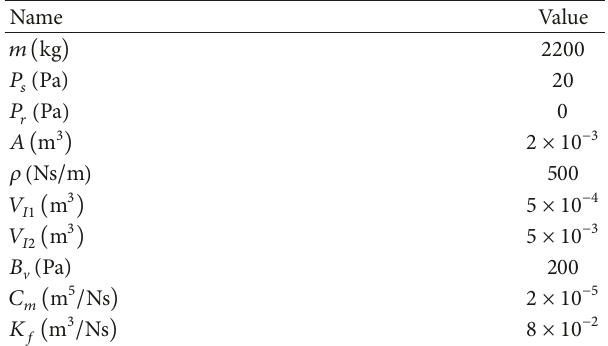
Table 1: The system parameters used in the